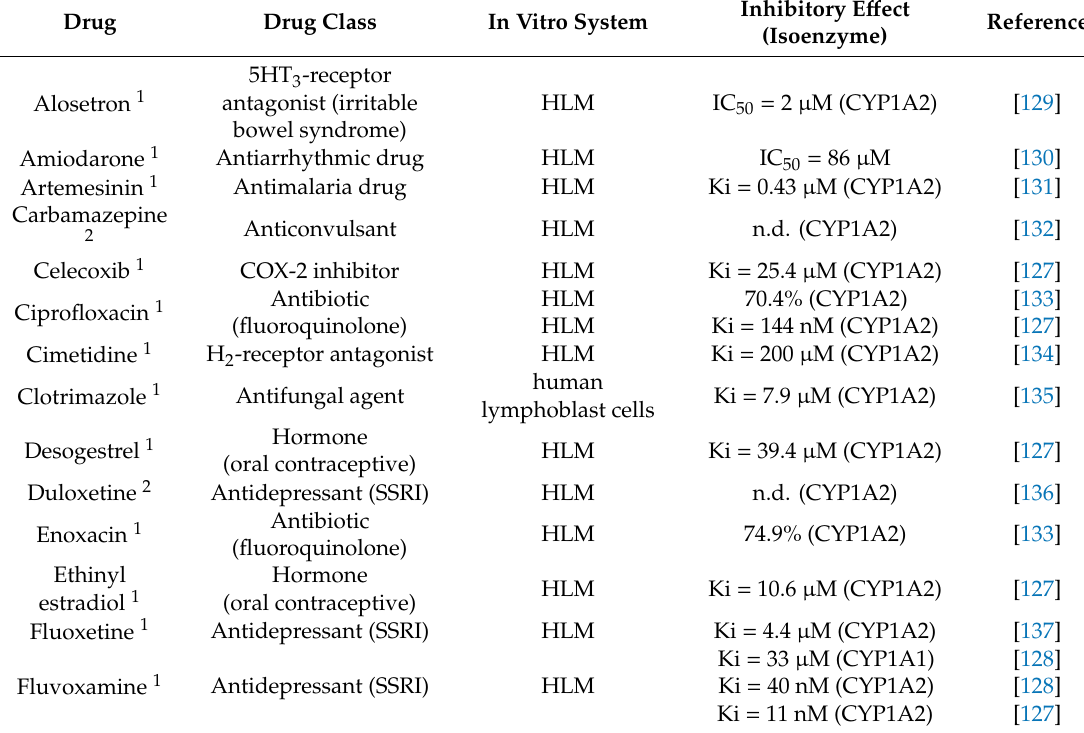
Table 4. Overview of clinically relevant drugs with inhibitory properties on CYP1A1 / 1A2.